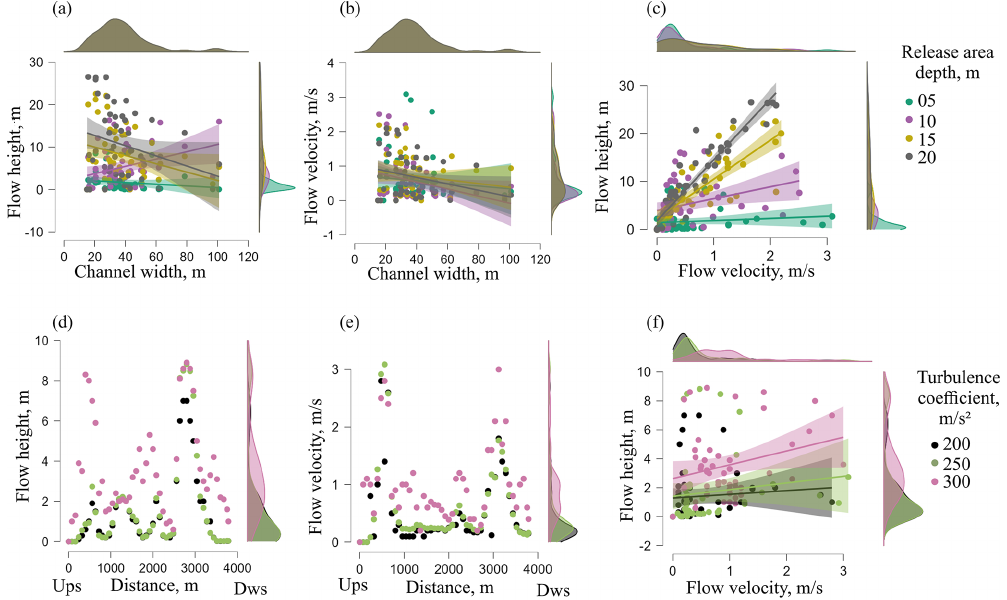
Figure 14. Relationship of channel width and debris flow characteristics (a–c) and results of sensitivity analysis at constant “maximum” friction and variable turbulence (d–f) . “Ups” and “Dws” refer to the upstream and downstream sides of the river channel, respectively.